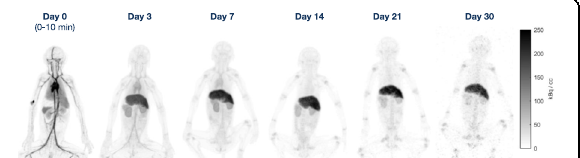
Fig. 2 (abstract A23). Maximum intensity projection images at each time-point for one of the nine monkeys. The monkey was injected with 43.6 MBq of 89 Zr-labeled antibody approximately three minutes before the start of the day 0 scan